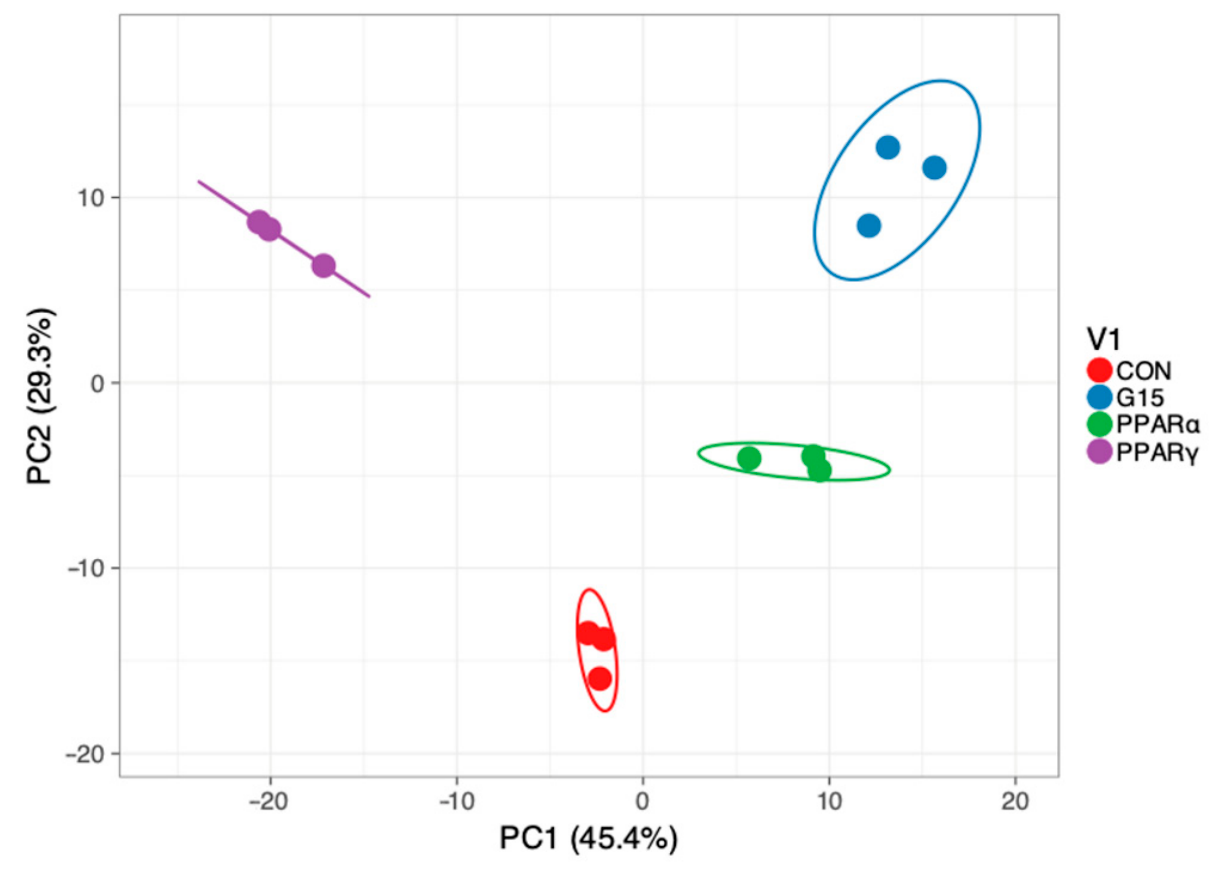
Figure 2. Principal component analysis and hierarchical clustering of samples based on genes with altered expressions. Global ANOVA test across PPAR α , PPAR γ and GPER antagonist-treated groups. (CON—control group, PPAR α —group treated with PPAR α antagonist, PPAR γ —group treated with PPAR γ antagonist, G15group treated with G15 antagonist).